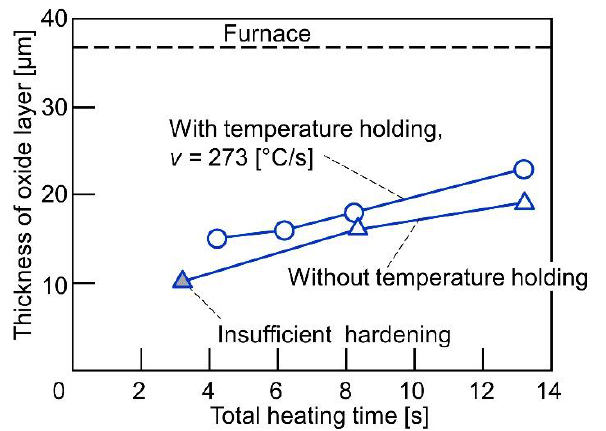
Figure 19. Effect of total heating time on thickness of oxide layer of hat-shaped bent parts in hot stamping using direct resistance heating.